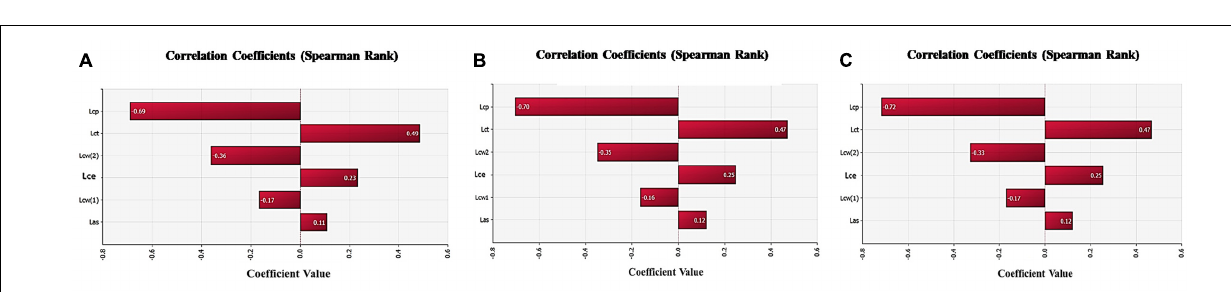
FIGURE 3 | Escherichia coli contamination simulated by exposure model of slaughterhouses of different sizes. (A) E. coli contamination simulated by exposure model of all slaughterhouses. (B) E. coli contamination simulated by exposure model of small swine slaughterhouses. (C) E. coli contamination simulated by exposure model of big swine slaughterhouses.